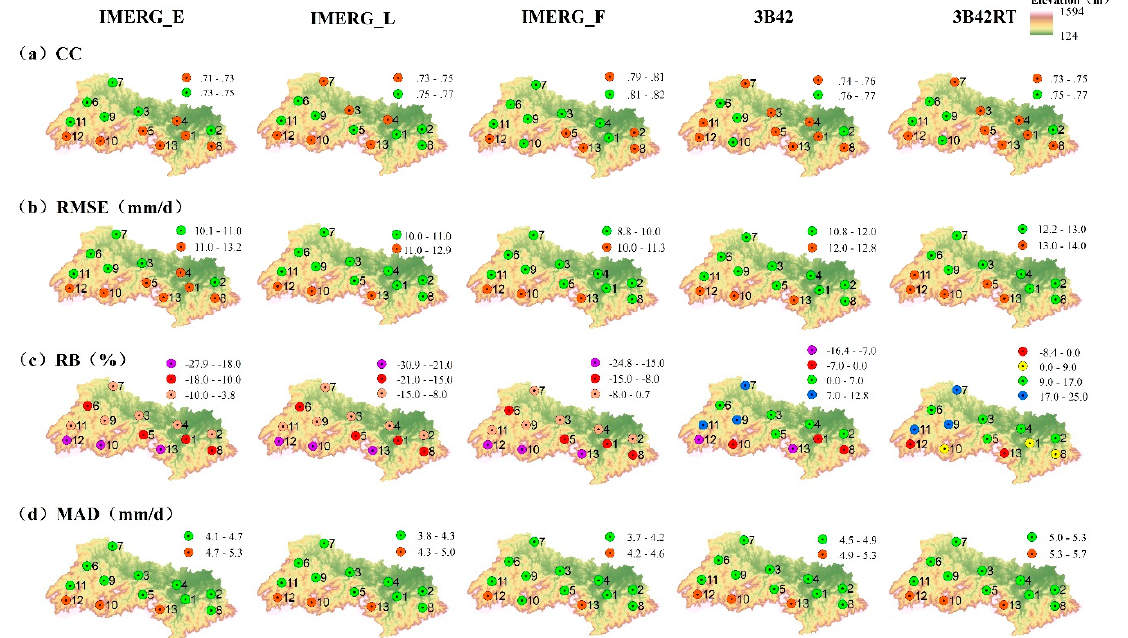
Figure 5. Spatial distribution of the annual continuous evaluation metrics at daily scale: ( a ) CC ; ( b ) RMSE ; ( c ) RB ; and ( d ) MAD .